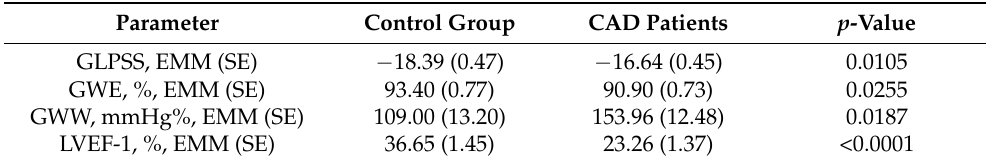
Table 2. ANCOVA of LV systolic function indices, which differed significantly in the unpaired tests (Mann–Whitney) between healthy controls and CAD patients. ANCOVA was adjusted for age, gender, and BMI, and the results are shown as the estimated marginal means (EMM) and standard error